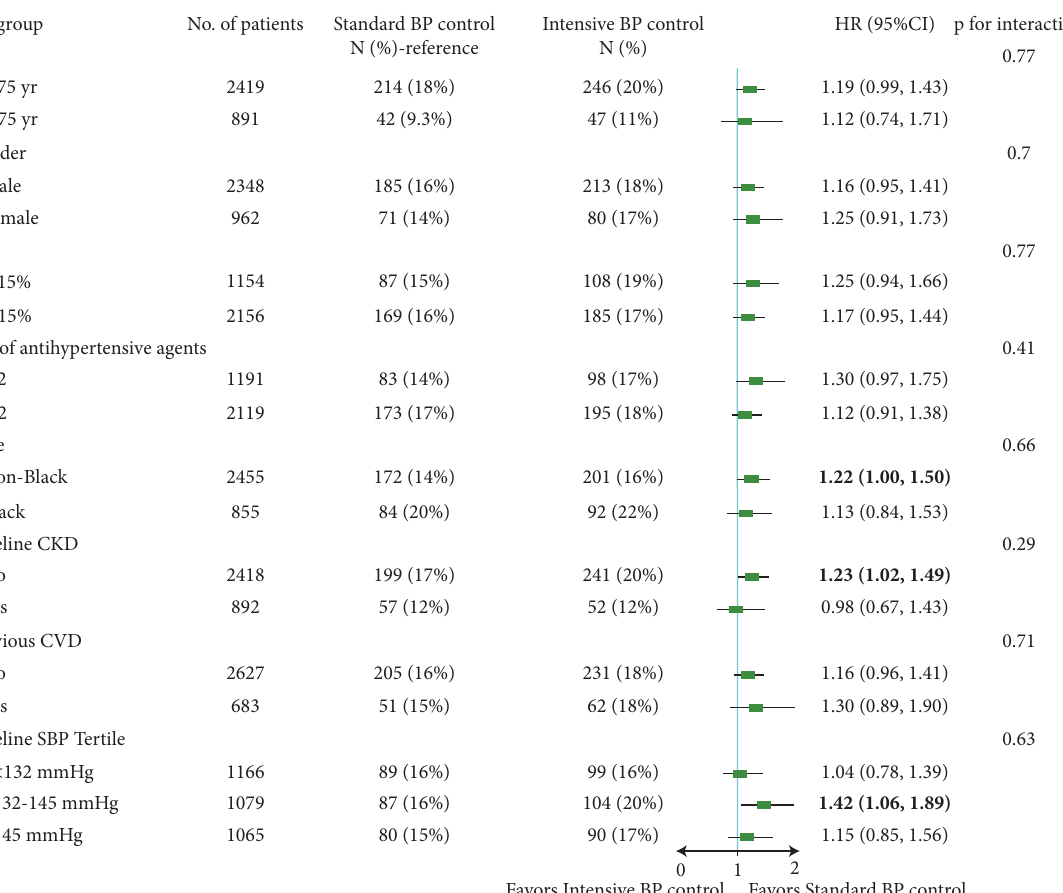
Figure 2: Risk of incident type 2 diabetes across subgroups between two treatment strategies. T2D: type 2 diabetes; BP: blood pressure; FRS: Framingham risk score; CKD: chronic kidney disease; CVD: cardiovascular disease; SBP: systolic blood pressure; HR: hazard ratio; CI: confdence interval; bold values mean statistical